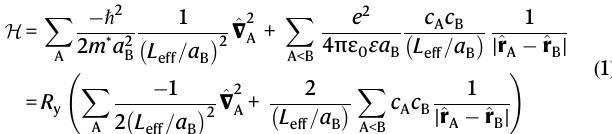
Fig.4|Scalinglawsofcharge-complexenergiesinlead-halideperovskitesingle NCs. Evolutions of the single-NC trion binding energies in R y units ( a ), biexciton binding energies in R y units ( b ) and dark-bright exciton energy splittings in R y2 = E gap units( c )asafunctionoftheexcitonrecombinationenergyexpressedin R y units after bandgap subtraction. The splittings and binding energies are measured with respect to the central line of the exciton triplet. Open blue triangles: CsPbBr 3 NCs; Open black squares: CsPb(Cl x Br 1-x ) 3 NCs; Green triangles: FAPbBr 3 NCs 30 ; Red circles: CsPbI 3 NCs 9 .Green squares: FAPbBr 3 NCs (data extractedfromref. 31 ).Plain blue triangle in ( a ): average data for 9nm sized CsPbBr 3 NCs 21 . Blue star in ( a ): CsPbBr 3 NC with 5.5nm size. Blue diamond in ( a ): CsPbBr 3 NC with 14.5nm size. Plain black square in ( a ): CsPbClBr 2 NCs from ref. 24 . Black diamond in ( a ): CsPb(ClBr) 3 NCs from ref. 42 . Red disks in ( a ) and ( b ): CsPbI 3 NCs 22 . For these